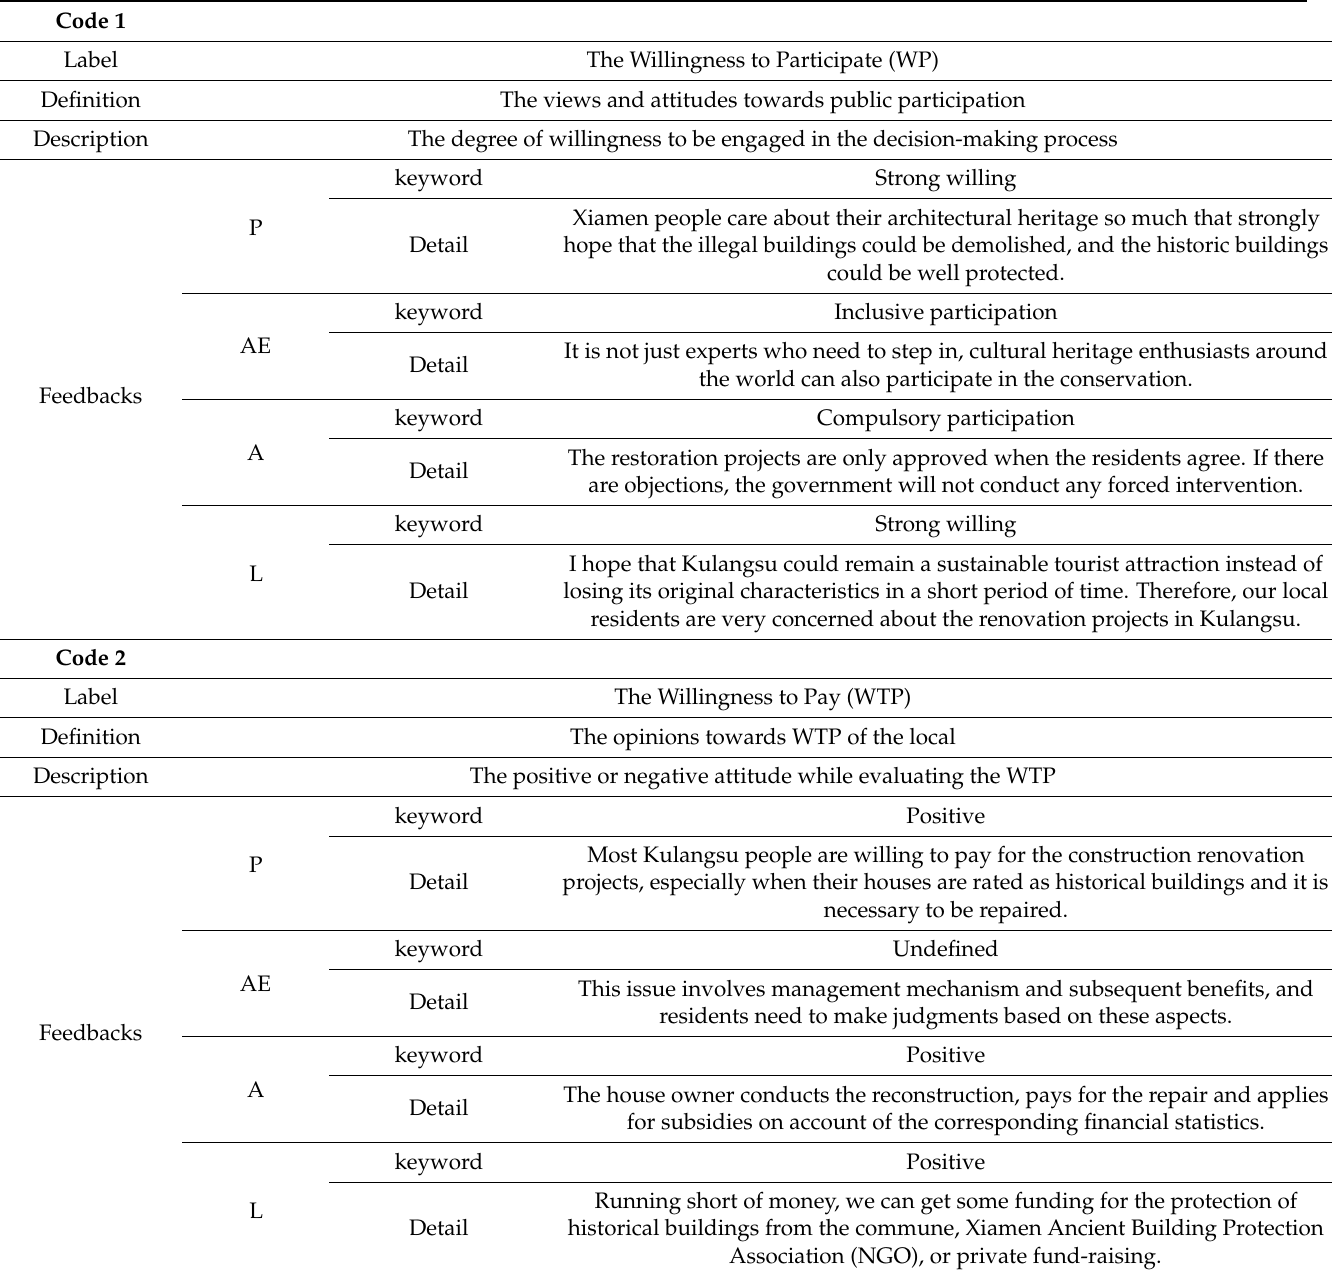
Table 11. Connecting the data-driven codes, identifying themes, and details (made by